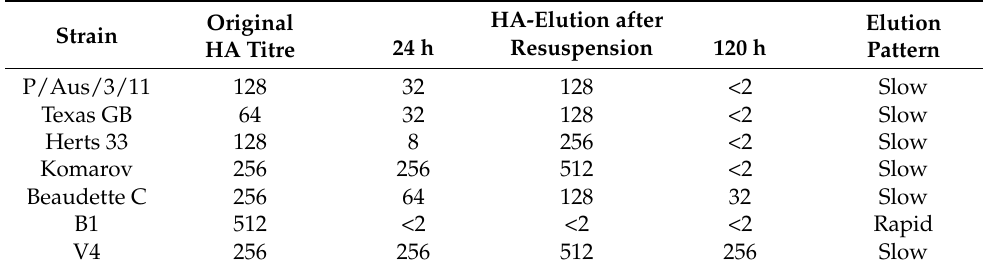
Table 3. HA-elution patterns of APMV-1 isolates.